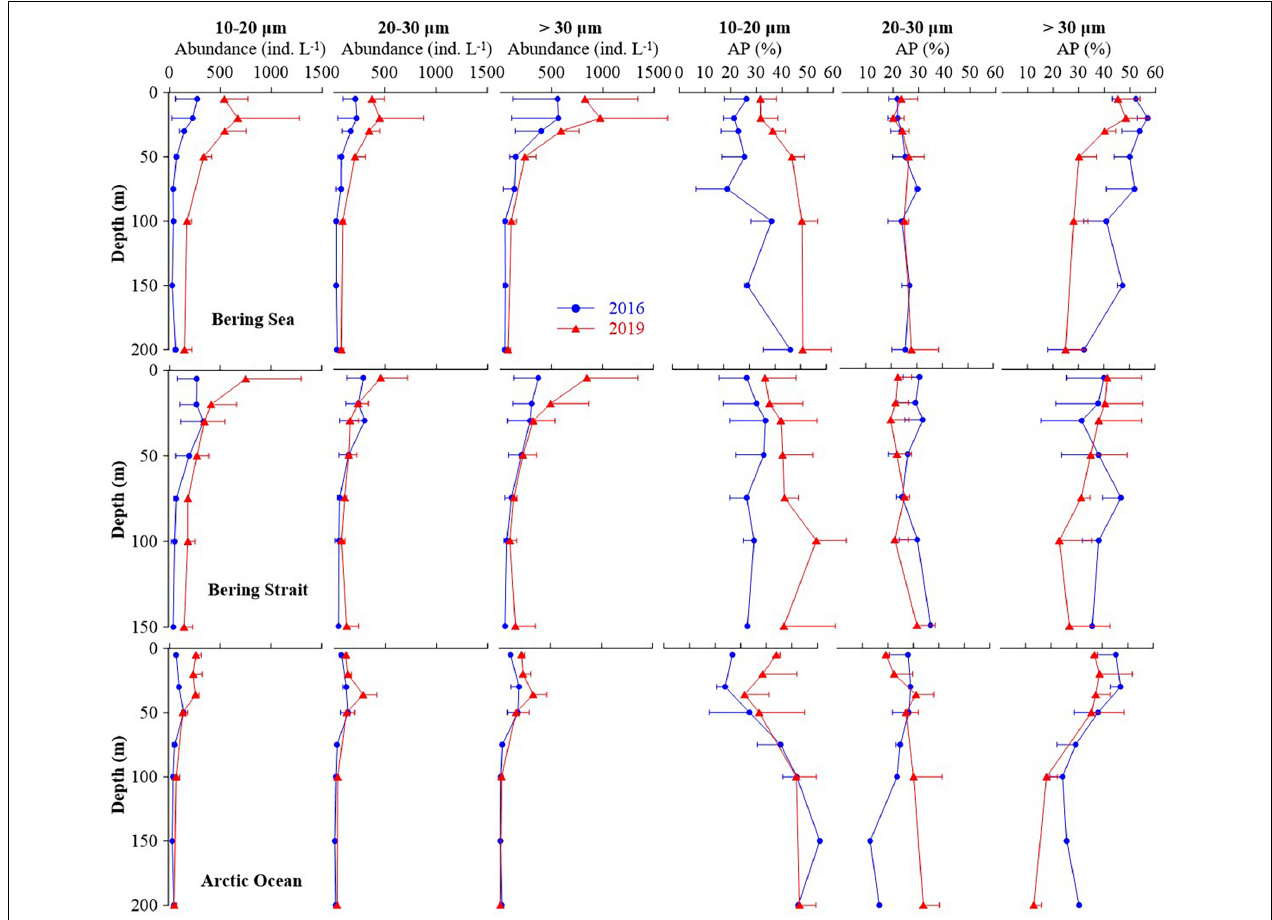
FIGURE 4 | Average abundance and abundance proportion of each aloricate ciliate size-fraction at each layers in the Bering Sea, Bering Strait, and Arctic